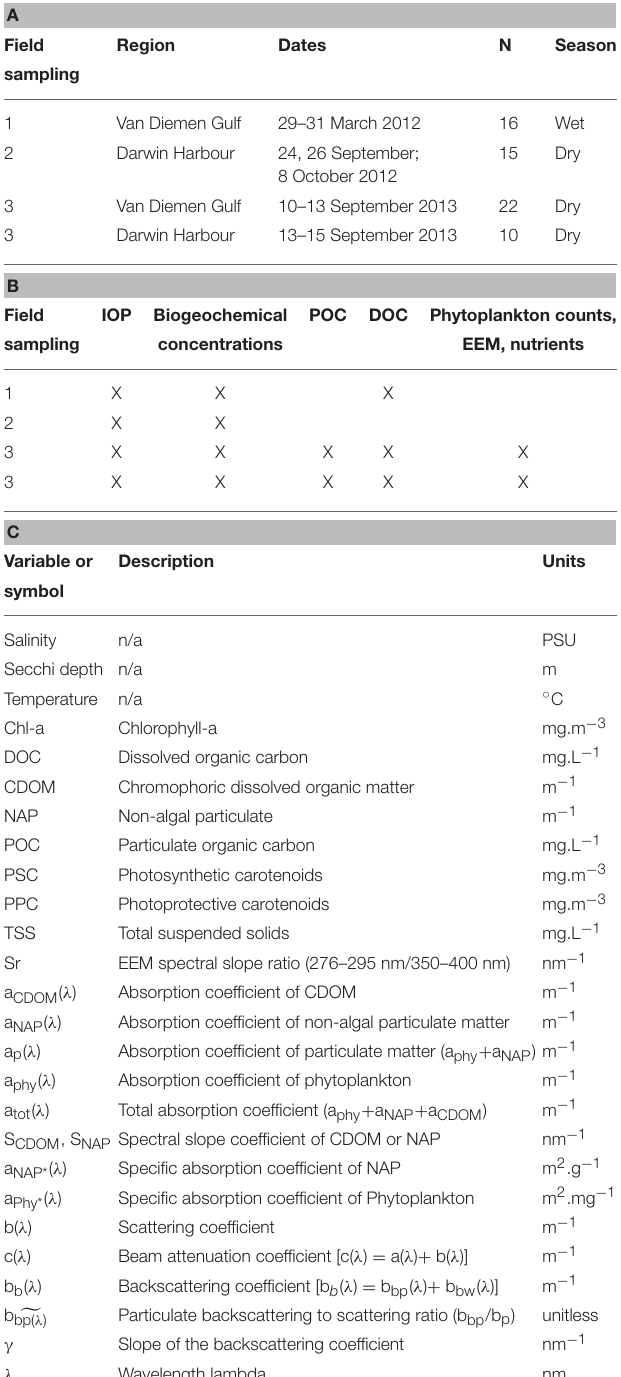
TABLE 1 | (A) Details of the seasonal field sampling and (B) the variables measured, (C) Notations: abbreviations, symbols and units of all the parameters referred to in this study.